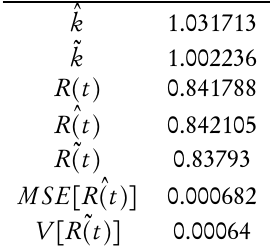
Estimates of k and R(t), variance and MSE under type II censoring.